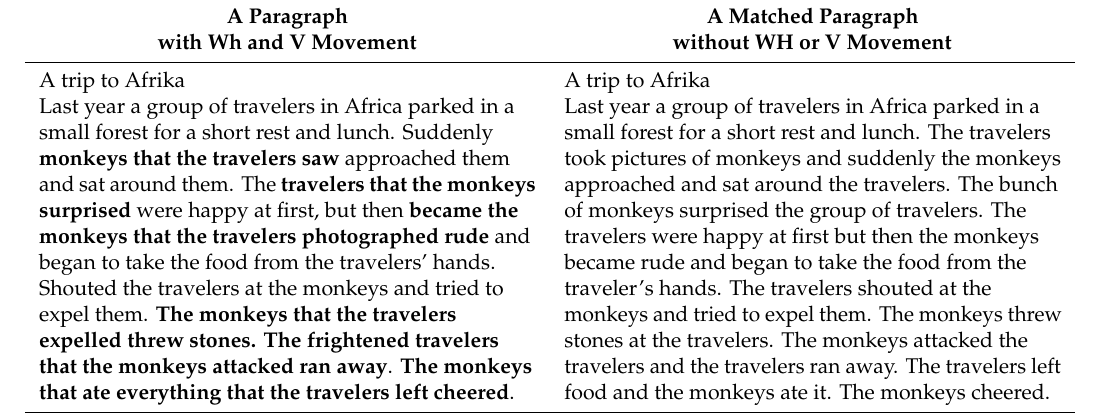
Table 3. An example for a pair of matched paragraphs, one with Wh and verb movement and one without. (The text is a translation from Hebrew that retains the original syntactic structures of the Hebrew text. Clauses with Wh- or verb-movement are marked in